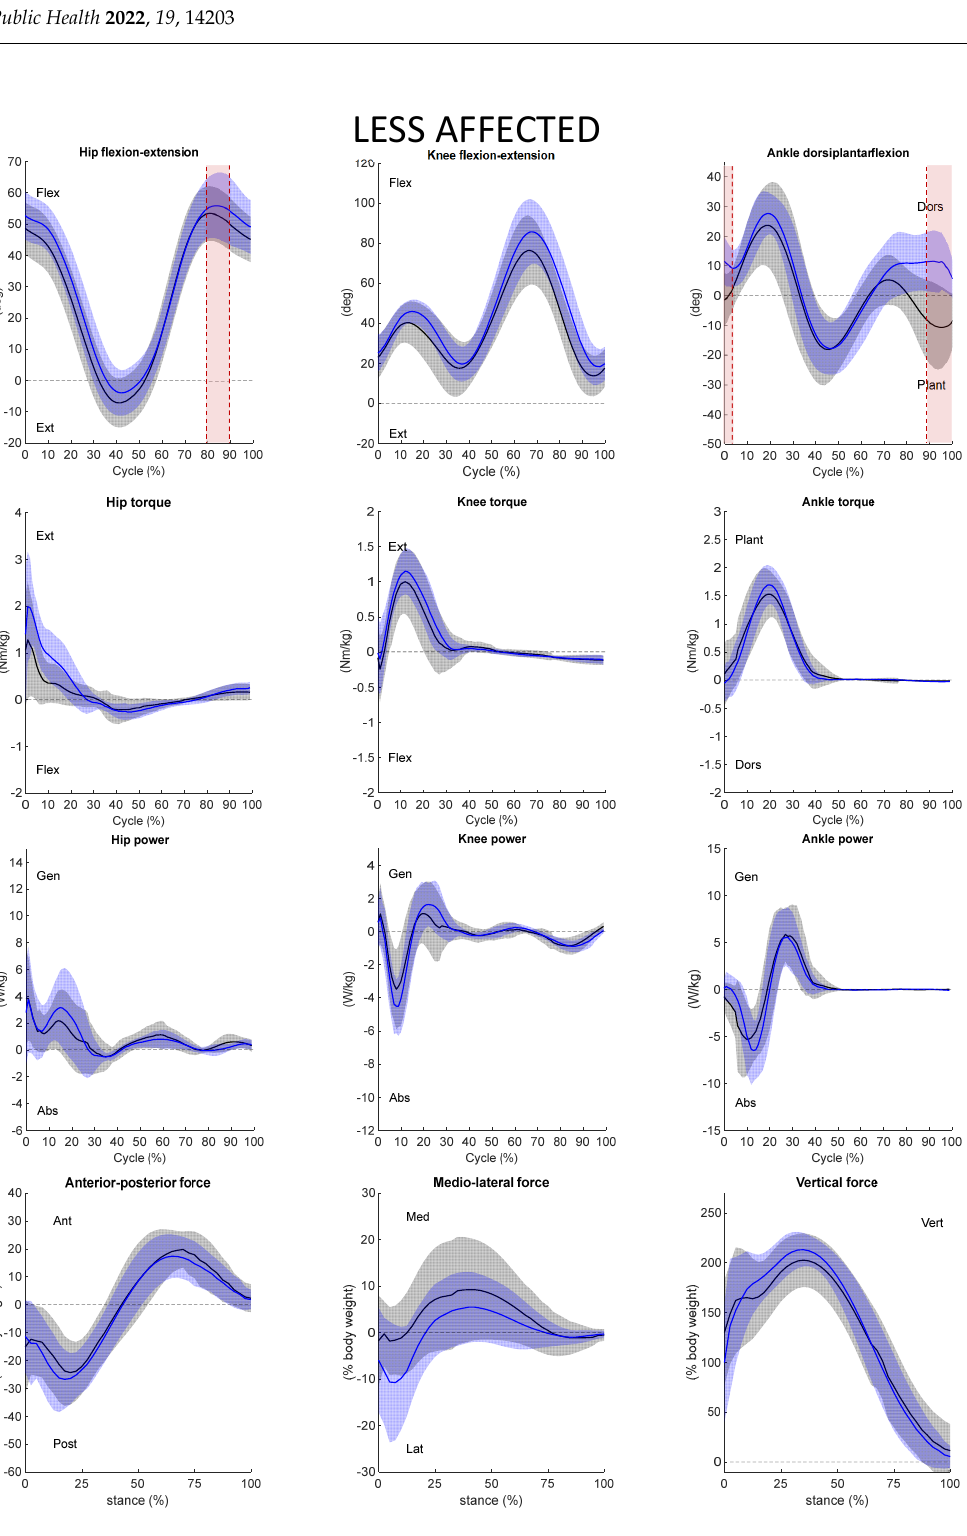
Figure 3. Hip knee ankle kinematic (1st line), torque (2nd line), power (3rd line), and ground reaction forces (4th line) of the less affected side. Kinematic and kinetic variables are expressed as a function of the running cycle (Cycle (%) or %GC) while GRFs have been normalized with respect to stance phase (stance (%)). Mean and SD of the barefoot (in black) and the orthotics (in blue) trials are represented. The SPM statistics results (SPM{t}) are shown in red. Flex = flexion; Ext = extension; Dors = dorsiflexion; Plant = plantarflexion; Gen = generated; Abs = absorbed; Ant = anterior; Pos = posterior; Med = medial; Lat = lateral; Vert =